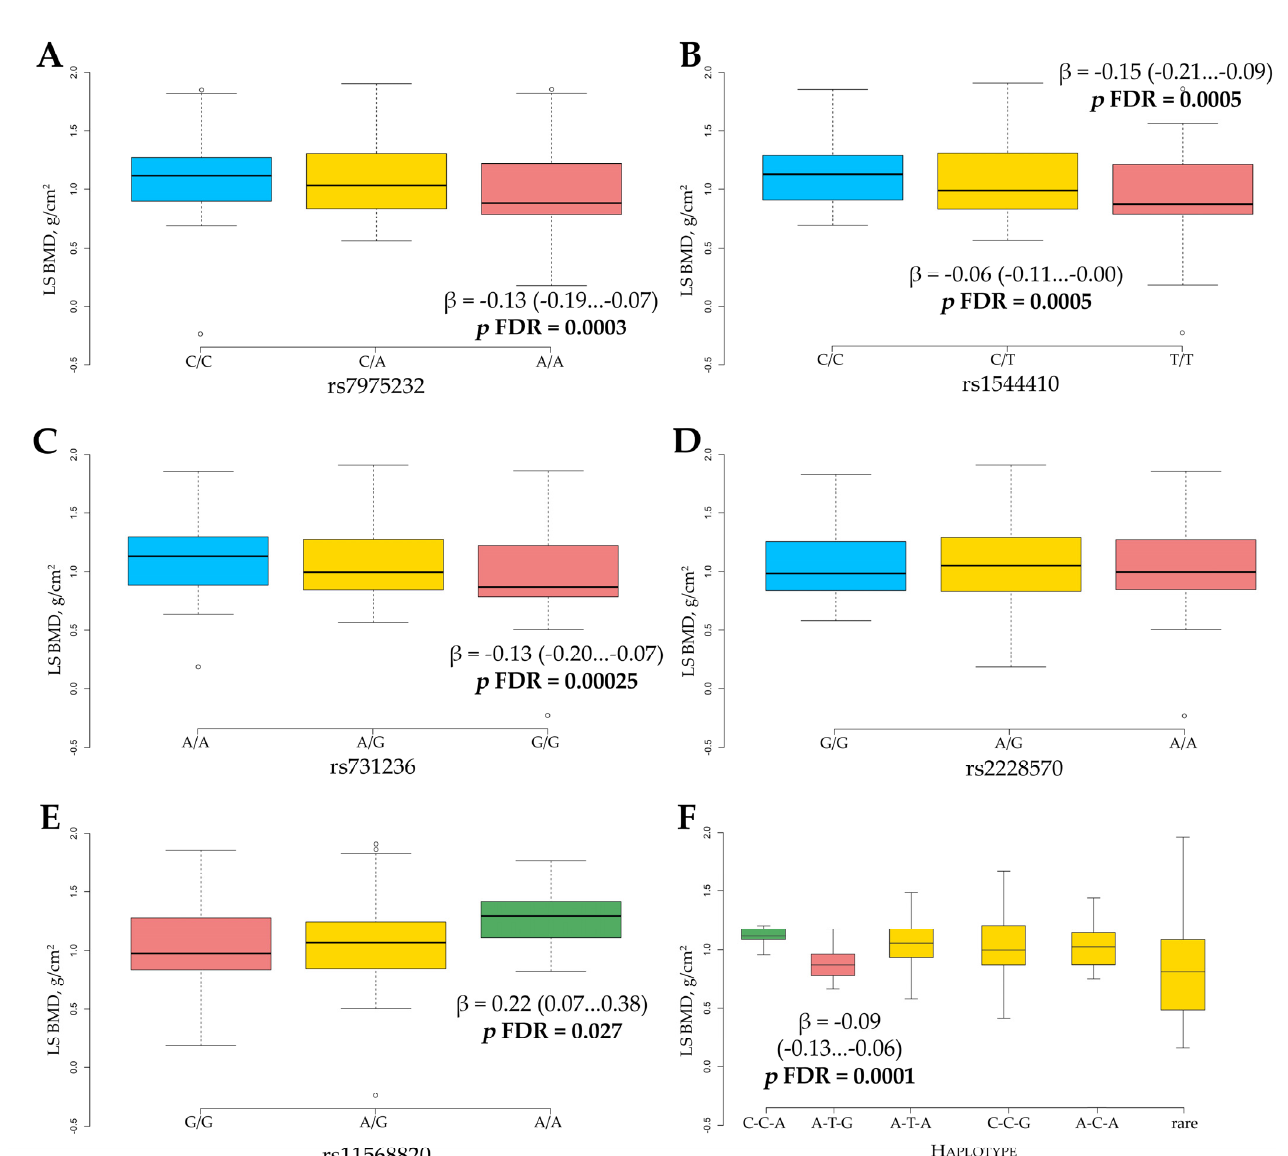
Figure 2. Lumbar spine (LS) BMD level in relation to VDR gene variants rs7975232 ( A ), rs1544410 ( B ), rs731236 ( C ), rs2228570 ( D ), rs11568820 ( E ), and rs7975232, rs1544410, and rs731236 haplotypes ( F ). For rs7975232, rs1544410, rs731236, and rs11568820 variants, gene/dose dependence was revealed. The rs11568820 was the only VDR gene variant with protective effect. p -values corrected for multiple testing using the FDR, β is the difference compared to the reference value. The data are presented as β (95% CI).